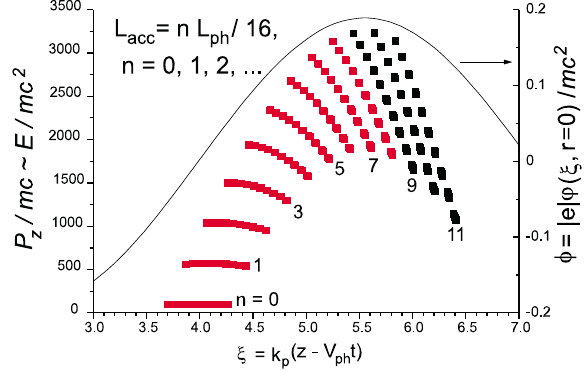
FIG. 2. (Color) Wakefield acceleration of an electron bunch by channel guided CO 2 laser pulse; a (cid:1) 0.71 , k p r L (cid:1) 3.8 , k p R ch (cid:1) 14.3 , L ph (cid:1) 512 cm, E inj (cid:1) 100 mc 2 , L b (cid:1) r b (cid:1) 0.1 l p .